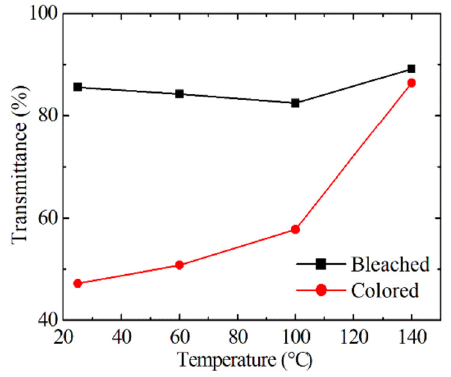
Figure 16. Transmittance in the bleached and colored states as a function of temperature.